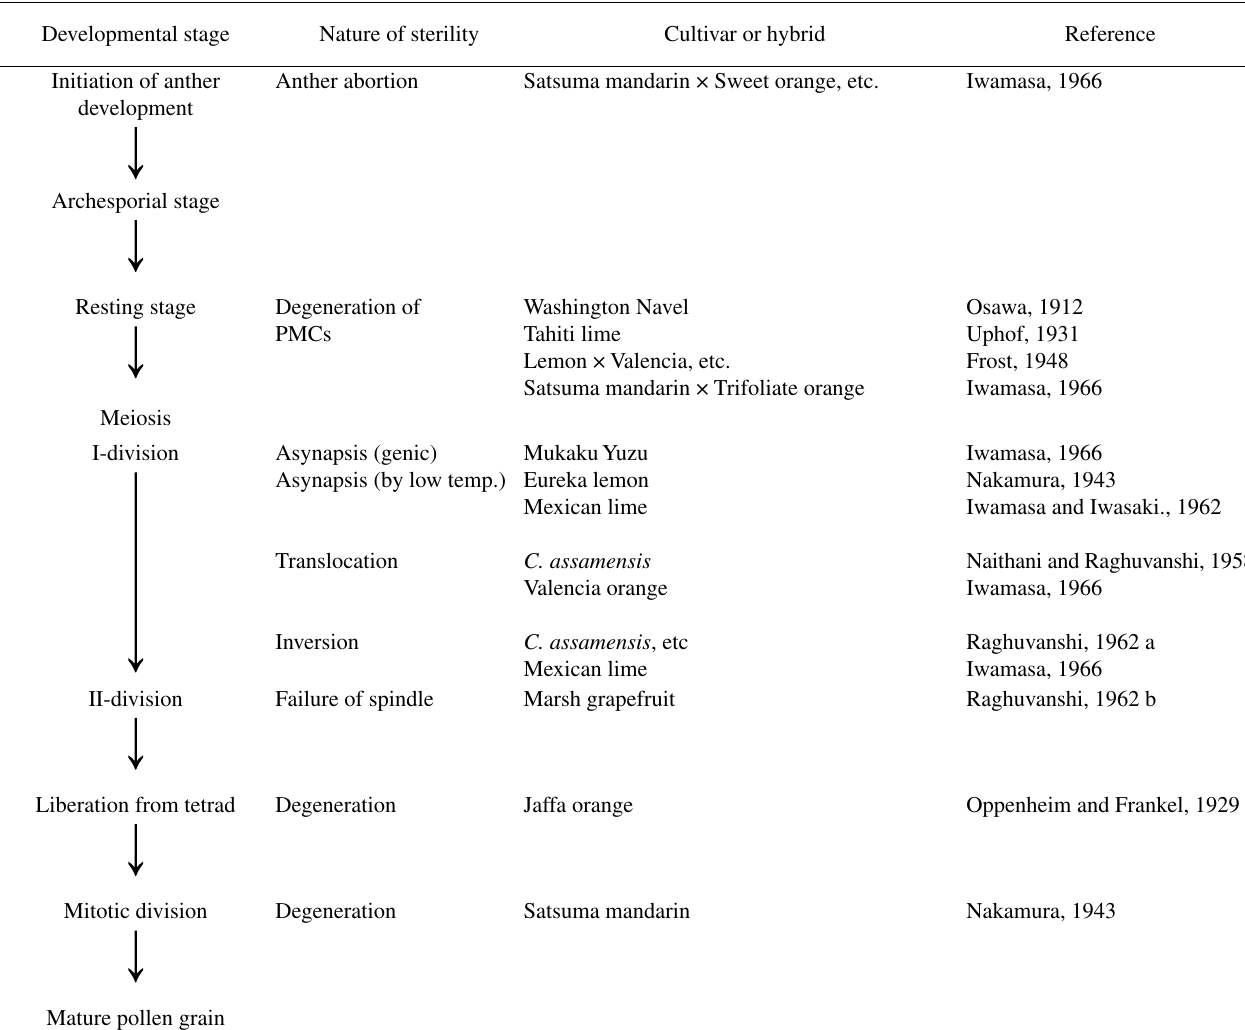
Table 1 - Diagramatic representation of various kinds of the male-sterility in citrus, according to the sequential order of development (Modified from Iwamasa, 1966)